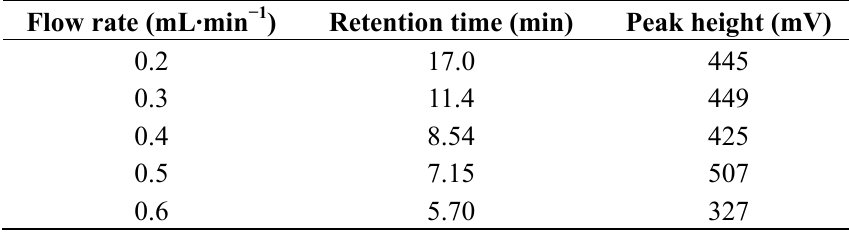
Table 2. Dependences of retention time and peak height of cysteine (2.5 mg·L − 1 ) on the flow rate (mL·min − 1 ) at carbon fiber detector (length 8